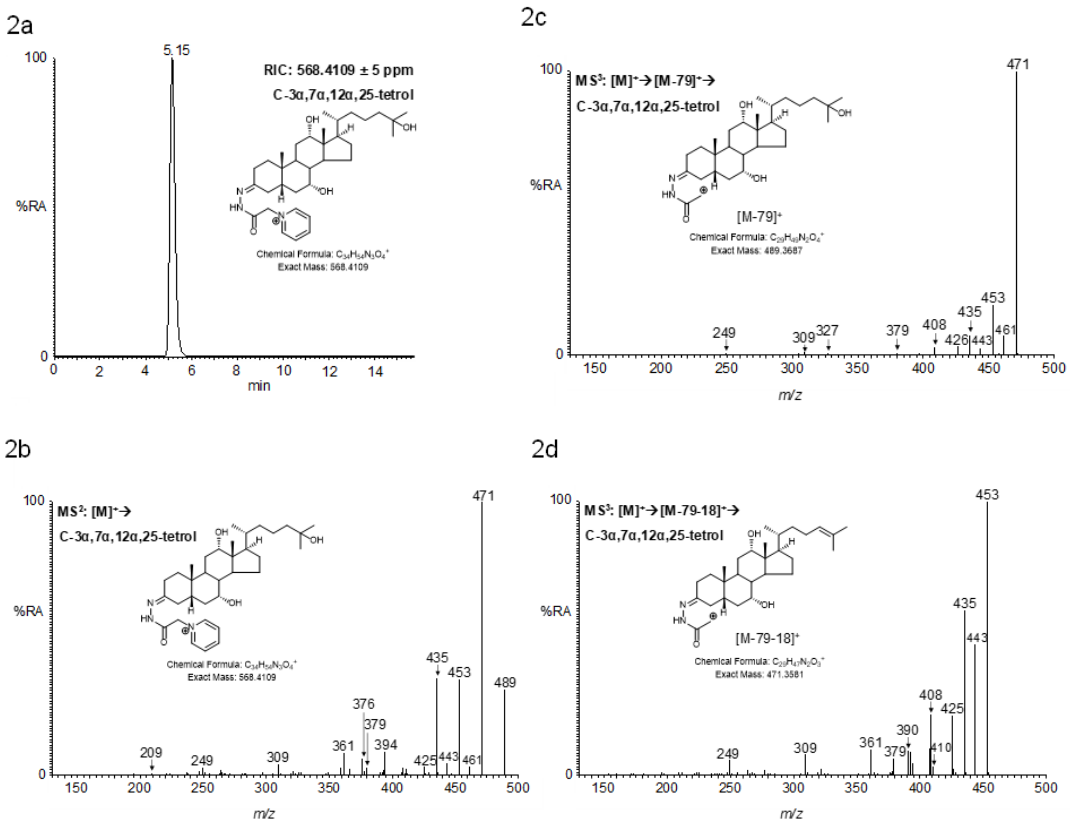
Figure 2. ( a ) RIC and ( b ) MS 2 ([M] + → ), ( c ) MS 3 ([M] + → [M-Py] + → ), ( d ) ([M] + → [M-Py-18] + → ) spectra of oxidized/GP-derivatized C-3 α ,7 α ,12 α ,25-tetrol. For comparison, MS 2 ([M] + → ) spectra of C-3 α ,7 α ,12 α -triol and C-3 α ,7 α ,12 α ,26-tetrol and the MS 3 ([M] + → [M-Py-18] + → ) spectrum of C-3 α ,7 α ,12 α ,26-tetrol are shown in Supplemental Figure S1a–c respectively. Mass spectra recorded at the peak of the RIC for these and other sterols analyzed are shown in Supplemental Figure S2. Data was generated on the Orbitrap-Elite mass spectrometer as in Figure 1. See Table 1 to correlate m / z with fragment ion composition .